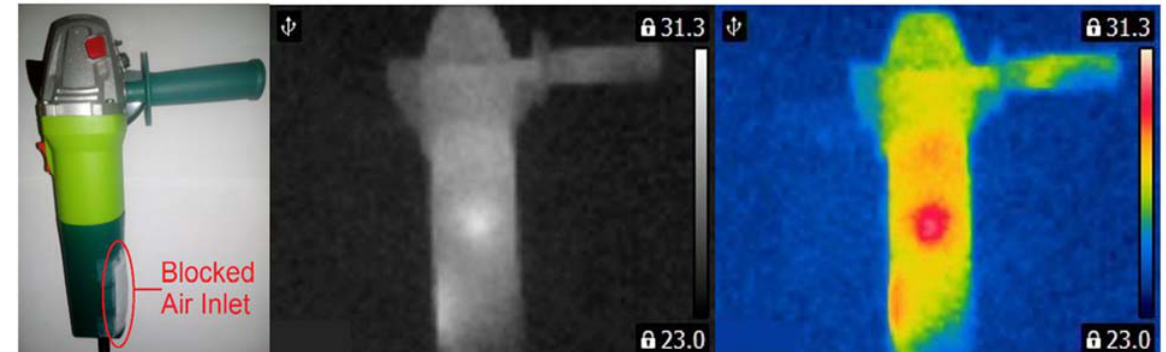
Figure 4. Angle grinder with 1 blocked air inlet.